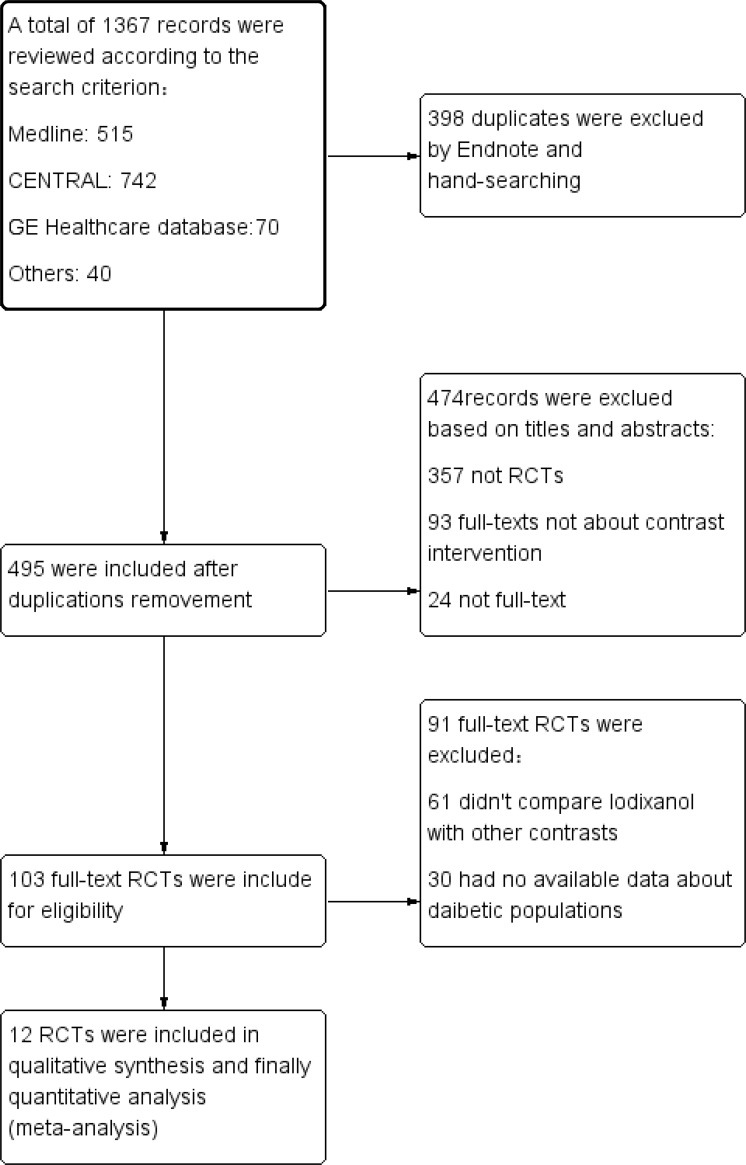
Flow diagram of selection strategy.Flow diagram depicting the selection strategy for trials used in this meta-analysis. 12 RCTs finally met our criteria. RCT = randomized clinical trials.